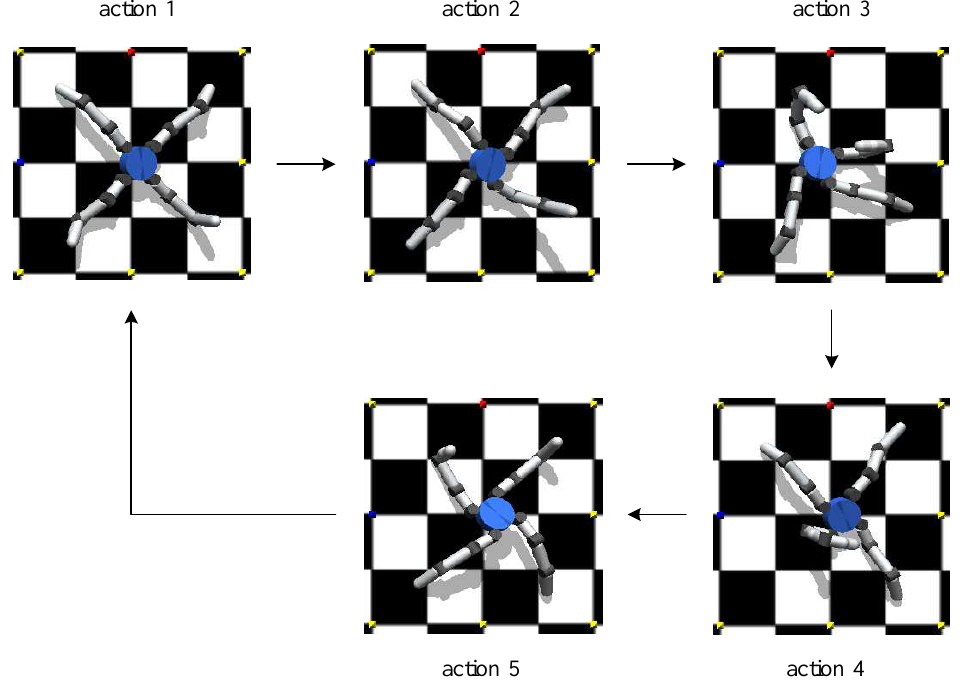
Figure 7. Example of robot movement with sequential actions. Robot will start executing from action 1 to action 5 continuously in round-robin